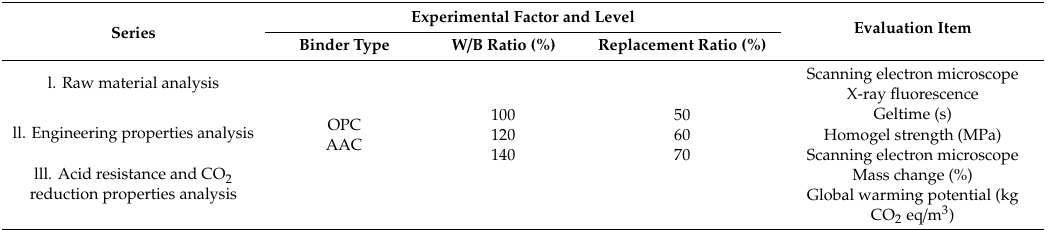
Table 3. Experimental plan.